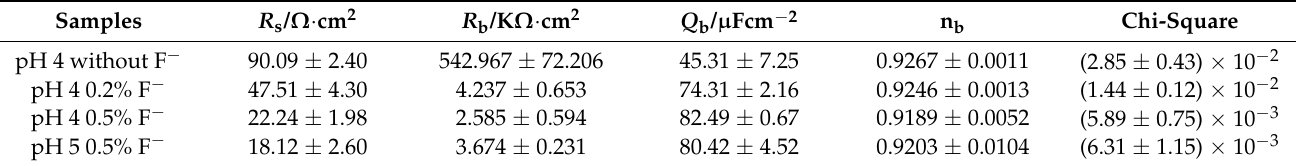
Table 2. EIS fitting parameters of SLM and wrought TiNi sample in